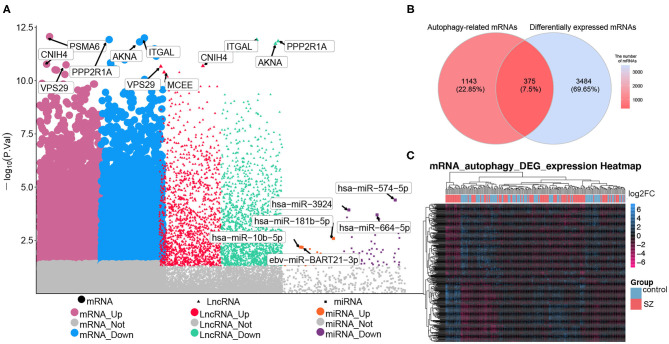
Differential expression analysis and screening of autophagy-related mRNAs. (A) Manhattan diagram showing differentially expressed (DE) lncRNAs, DEmiRNAs and DEmRNAs in schizophrenia (SZ). (B) Genes overlapping between the set of autophagy genes and the set of DEmRNAs. (C) Heatmap showing the expression of autophagy-related DEmRNAs. Yellow means up-regulation, blue means down-regulation.